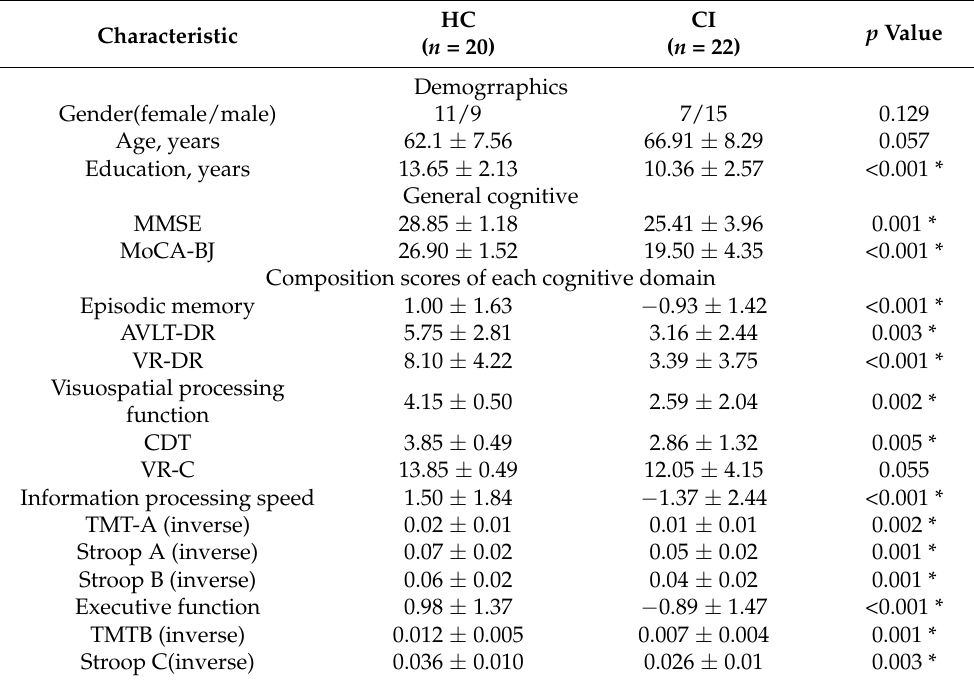
Table 1. Demographics and clinical characteristics of HC and CI subjects.